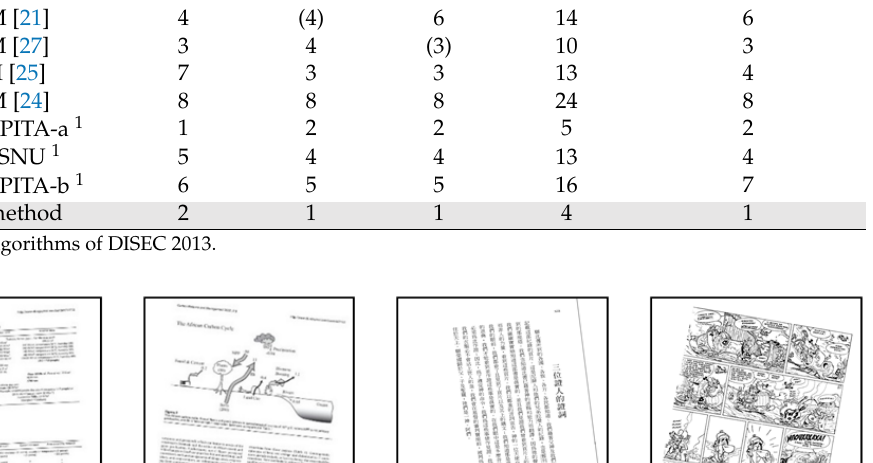
Table 7. Overall ranking on DIESC’2013 dataset.